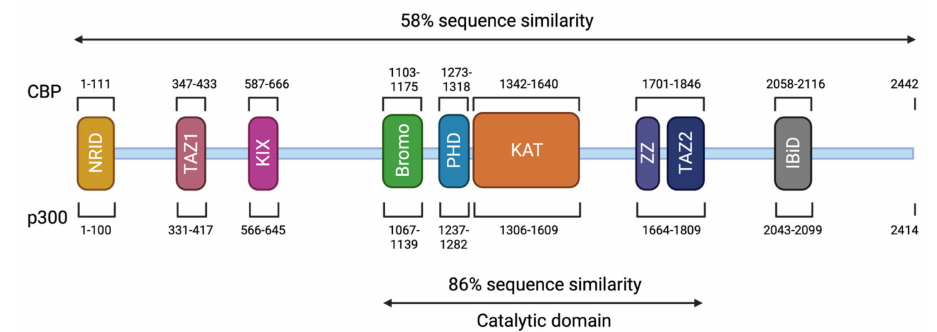
Figure 3. Structure of CBP and p300. The CBP protein is composed of 2442 amino acids (AA) and has a molecular weight of approximately 265 kDa. The p300 protein is composed of 2414 AA and has a molecular weight of approximately 265 kDa. These two proteins present 58% of sequence similarity within their domains. The different domains are represented and correspond to an N-terminal nuclear receptor interaction domain (NRID or RID), three cysteine-histidine rich regions (C/H1 and C/H3 domains contain zinc finger transcriptional adapters (TAZ1 and TAZ2), and C/H2 contains a homeodomain (PHD)), a KIX domain, a Bromodomain, a Lysine acetyltransferase domain (KAT) and an interferon-binding transactivation domain (IBiD). The position of the different domains is indicated relative to the position in the amino acid sequence. The catalytic domain has been highly conserved during evolution with 86% of similarity between CBP and p300 including the KAT domain and flanking